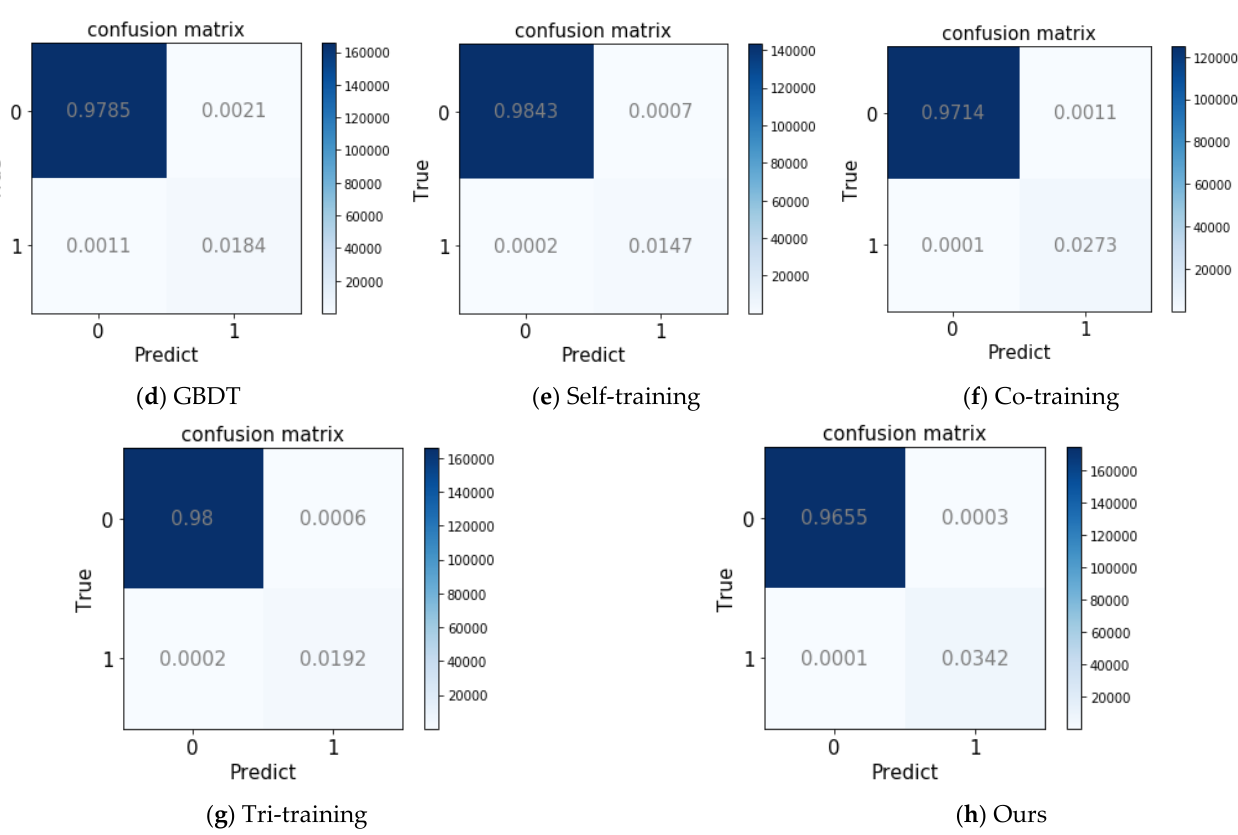
Figure 5. The confusion matrix for each model: ( a – h ) the confusion matrices obtained using the edX dataset with different models when K = 2 and train:test = 5:5.